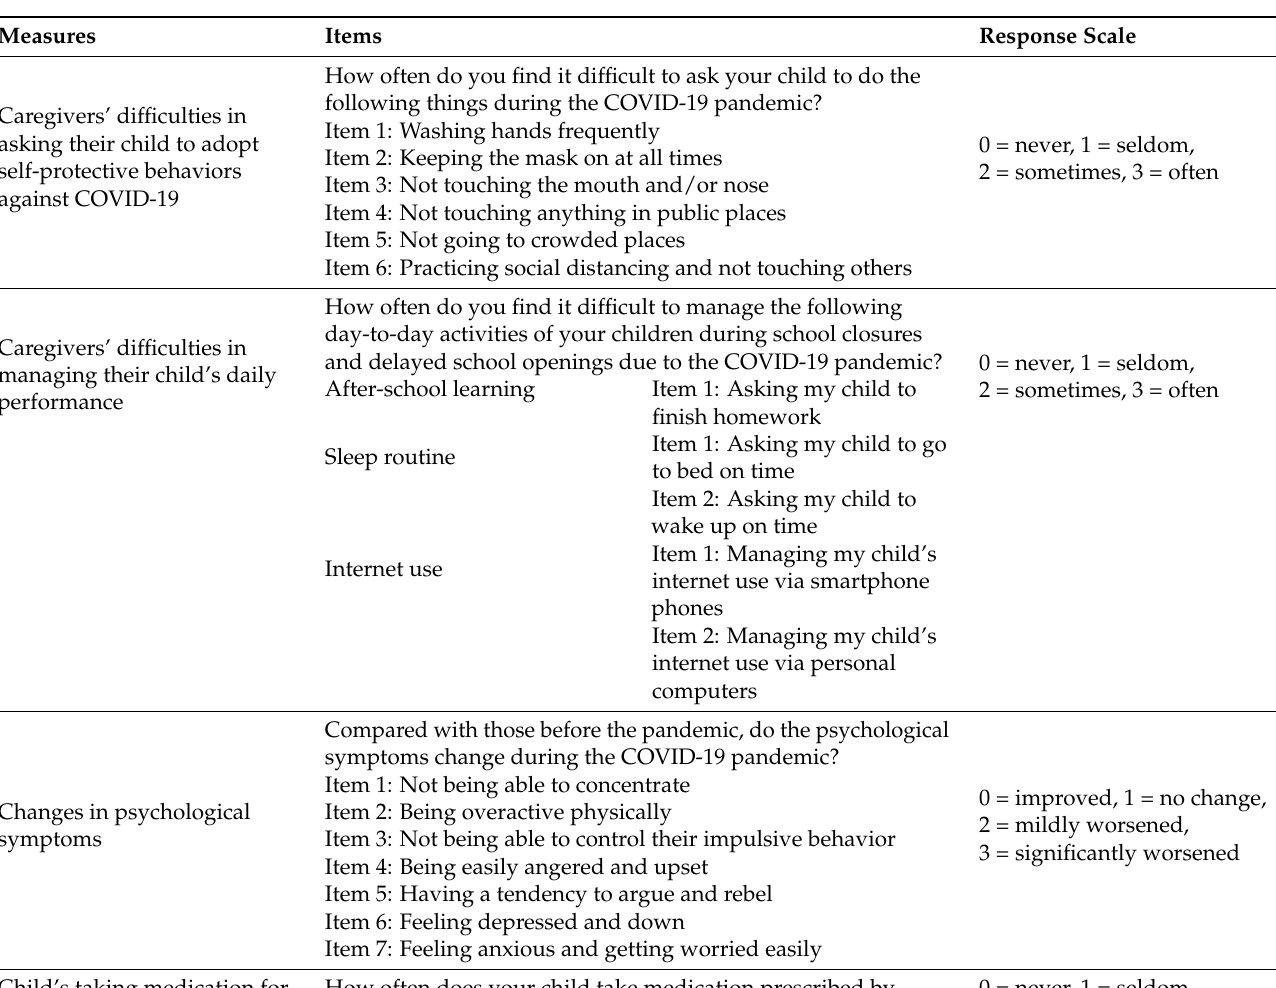
Table 1. Contents of the Research